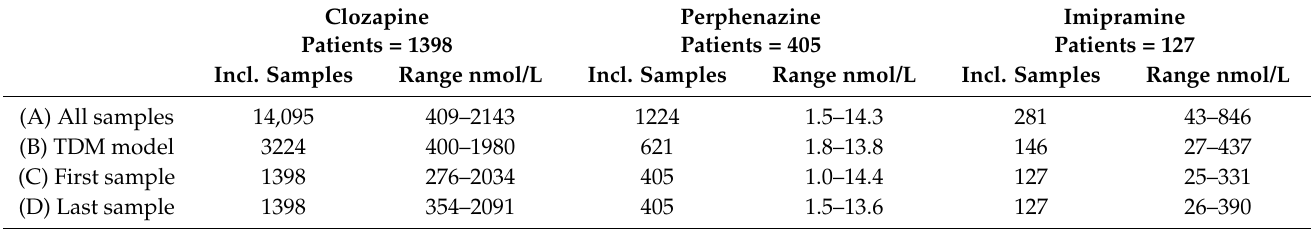
Table 1. Therapeutic analytical ranges for clozapine, perphenazine, and imipramine calculated based